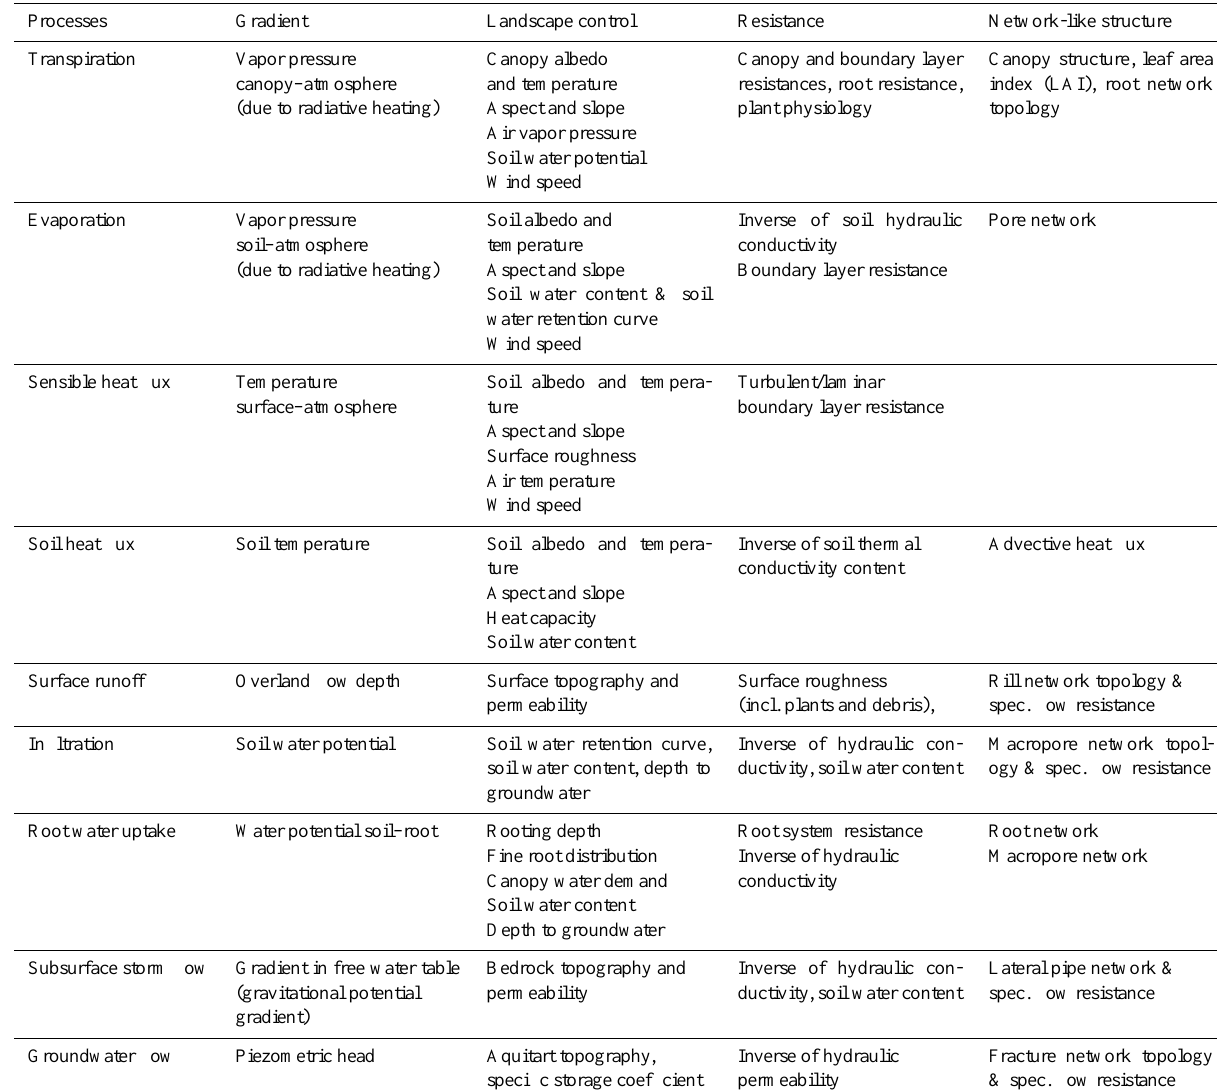
Table 1. Gradients and resistances determining fluxes/storage of water and energy as well as their landscape controls, with special emphasis on the influence of connected network-like structures that reduce